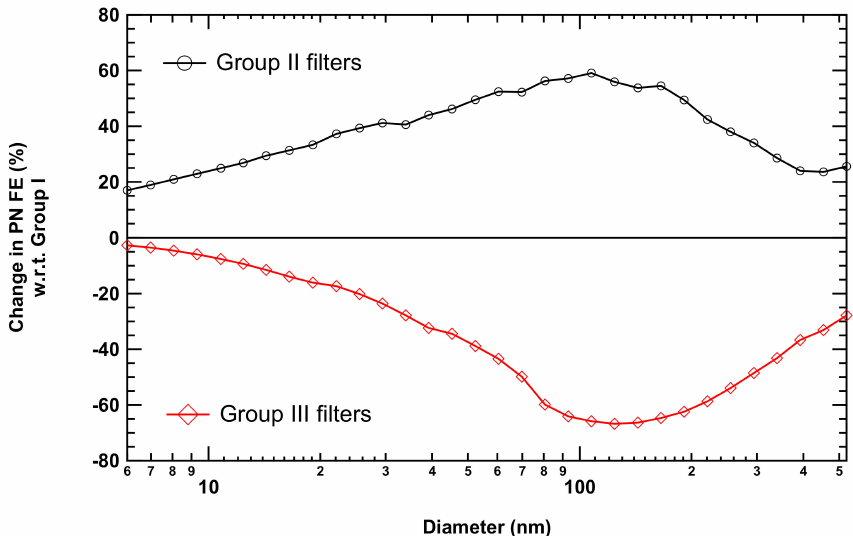
Figure 7. Percentage difference in PN FE for the Group II (electrostatic filters) and Group III (under- performing filters) with respect to Group I (nominal